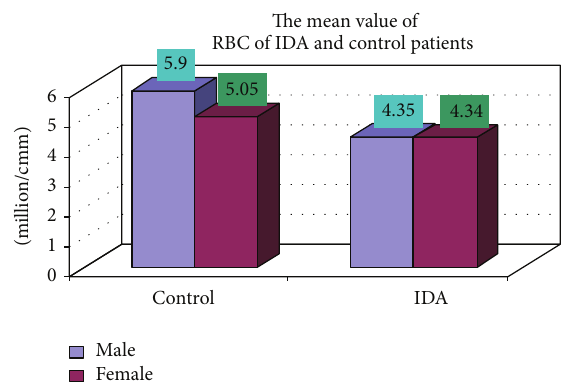
Figure 6: Showing the mean value RBC of control and iron deficiency anaemia.